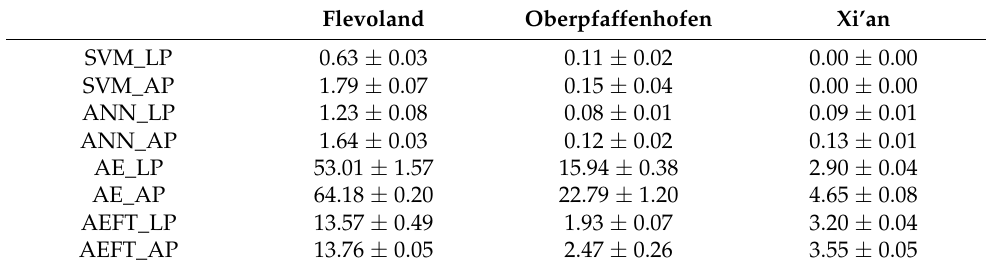
Table 18. Training time of four classifiers for parameter representative learning on three PolSAR datasets.